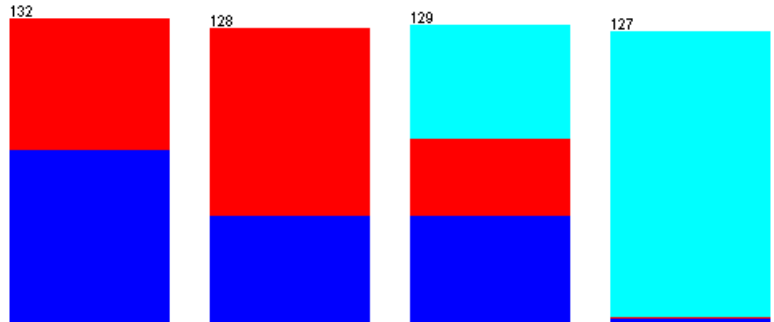
Figure 4. Visualization of Ni data after dividing them into four intervals with a similar number of data per interval (127−132), where Resample has equalized the weight for every class. The interval that corresponds to the lowest Ni content appears first from the left; intervals are ordered from left to right (Ni content increases to the right). This figure shows that, in the interval where nickel levels are the highest, most data correspond to serpentine soils (cyan), whereas only a few of them are from dolomite (blue), and the proportion of gypsum soils (red) is even